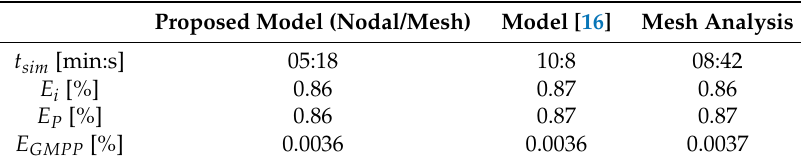
Table 5. Simulation time and mean absolute percentage errors for the irregular simulation